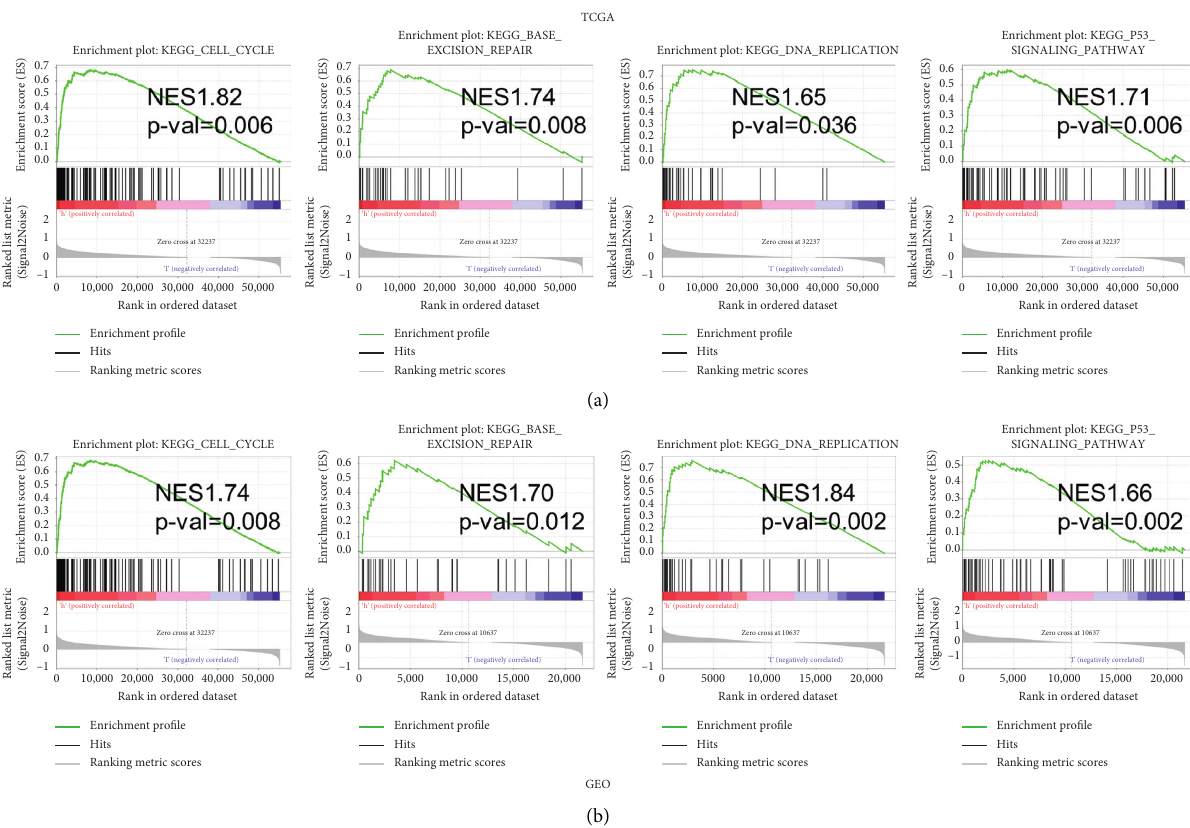
Figure 5: GSEA for identifying the ferroptosis-associated signaling pathways. (a) GSEA of the associated signaling pathway in TCGA cohort. (b) GSEA of the associated signaling pathway in GEO cohort.